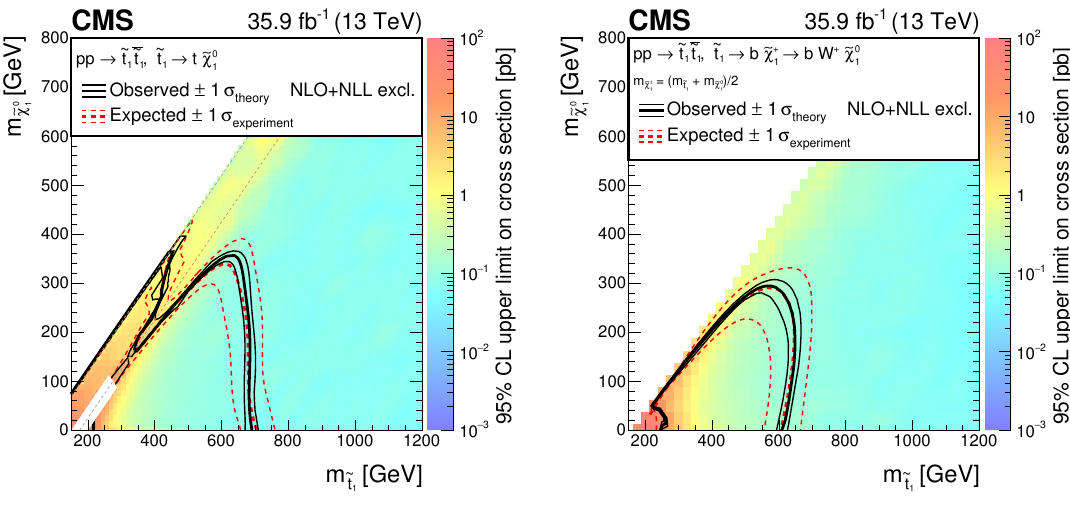
Figure 9 . Upper limits at 95% CL on top squark production cross section as a function of the top squark and neutralino masses. The plot on the left shows the results when top squark decays into a top quark and a neutralino are assumed. The two diagonal gray dashed lines enclose the . m (cid:0) m compressed region where m W < m t . The plot on the right gives the limits for top e t 1 e (cid:31) 0 1 squarks decaying into a bottom quark and a chargino, with the latter successively decaying into a W boson and a neutralino. The mass of the chargino is assumed to be equal to the average of the top squark and neutralino masses. Exclusion regions in the plane ( m , m ) are determined e t 1 e (cid:31) 0 1 by comparing the upper limits with the NLO+NLL production cross sections. The thick dashed red line shows the expected exclusion region. The thin dashed red lines show the variation of the exclusion regions due to the experimental uncertainties. The thick black line shows the observed exclusion region, while the thin black lines show the variation of the exclusion regions due to the theoretical uncertainties in the production cross